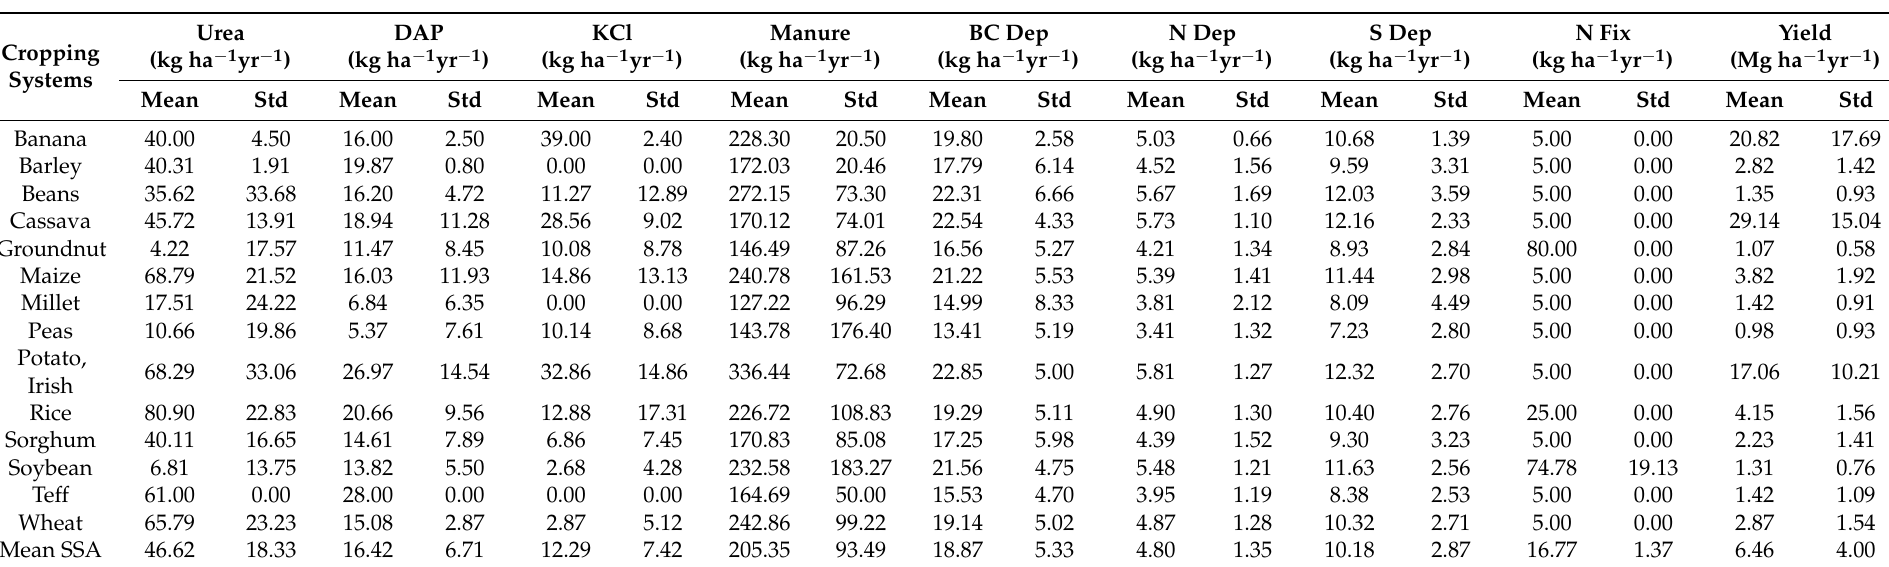
Table 2. Descriptive statistics of mineral fertilizer use, manure, nutrient deposition, and crop yield of different cropping systems in Sub-Saharan